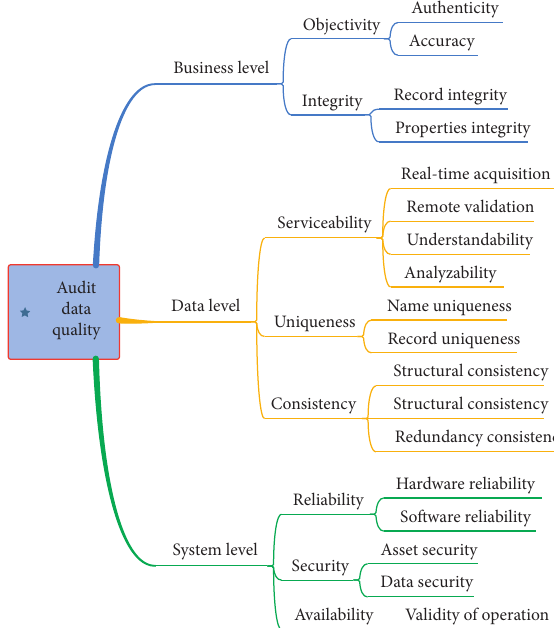
Figure 2: Audit data quality